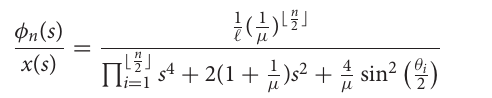
FIGURE 3 | Schematic of (A) the actual pendulum chain with varying masses and (B) the equivalent diatomic lattice with varying stiffnesses. (C) Frequency response diagram for the actual and equivalent systems for n schematic of the steady state responses of the pendulums with varying masses at four distinct excitation frequencies (marked p 1 Numerical dispersion contours constructed from the actual chain of pendulums showing agreement with the analytical dispersion relations (black dashed-line) obtained from the equivalent system via Equation